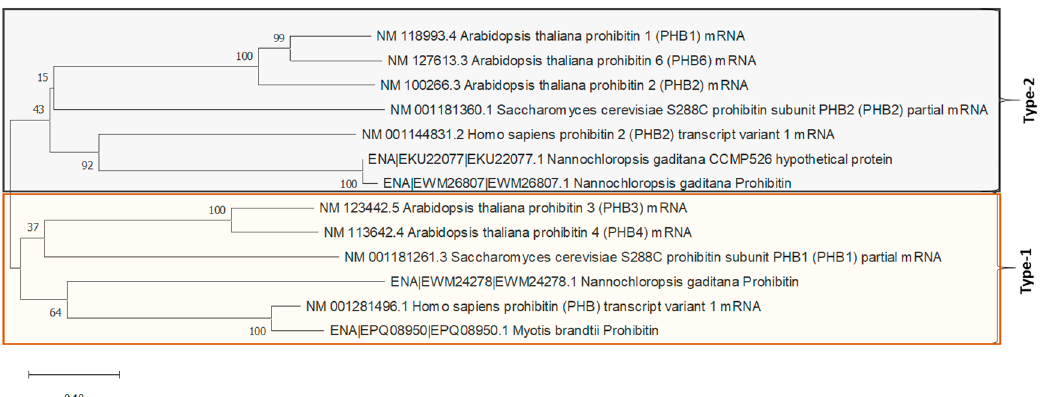
Figure 1. Evolutionary relationships of several described prohibitin nucleotides sequences and the 3 putative prohibitin of N. gaditana. Evolutionary analyses were conducted in MEGA X using pairwise deletion option 57. The phylogenetic tree was constructed using the Neighbor-Joining method [52] for the evolutionary history and the Maximum Composite Likelihood method [53] to compute the evolutionary distances. The bootstrap test was evaluated by 1000 replicates and the results are shown next to the branches [54].